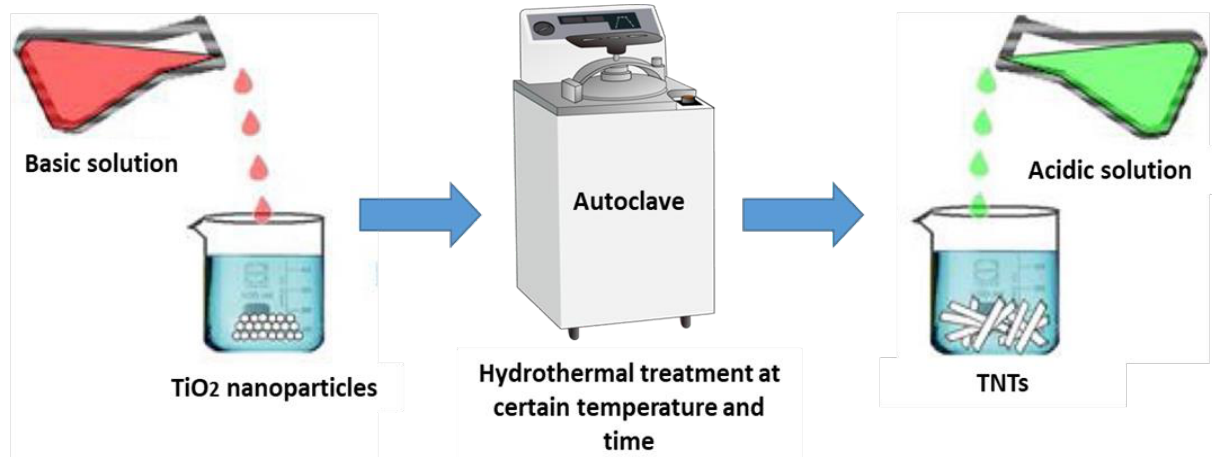
Figure 3. Synthesis of TNTs via catalyst-assisted VLS.